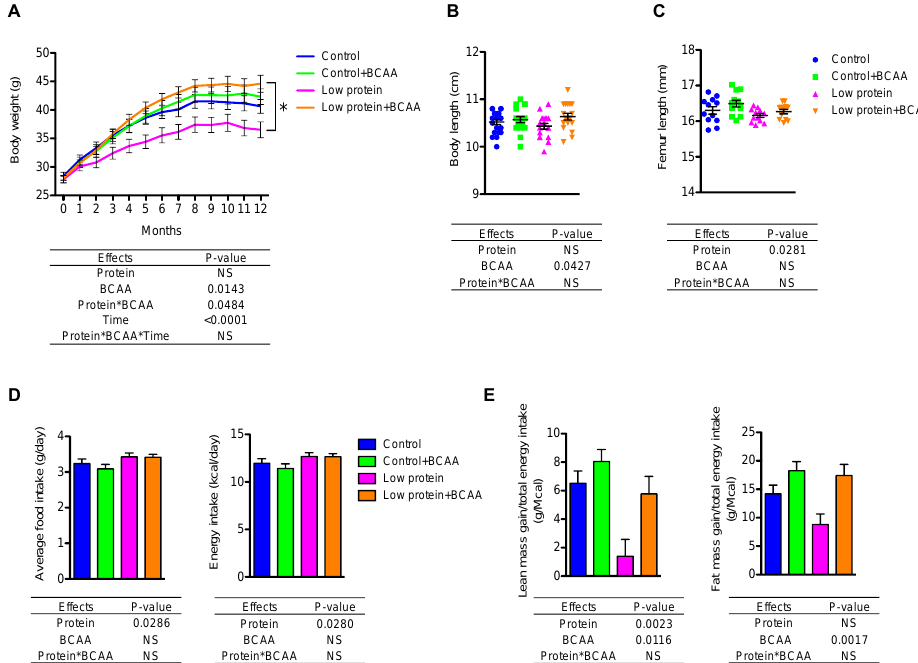
Figure 1. BCAA supplementation conditionally increased body weight in mice fed a low protein diet. Body weight ( A ), body length ( B ), and femur length. ( C ) were measured ( n = 12 – 20 mice/group). The average daily food intake (g/cage/day normalized by the number of mice per cage) and energy intake (kcal/cage/day normalized by the number of mice per cage) ( D ) and lean and fat mass gain normalized to energy intake ( E ) were also calculated ( n = 6 – 7 cages/group). Data represent mean ± standard error of the mean (SEM). Statistical analyses of main effects (protein, BCAA, and time) and interactions (protein*BCAA and protein*BCAA*time) are shown below each graph. * p < 0.05 for low protein vs. low protein + BCAA in panel A. BCAA : Branched-chain amino acids .